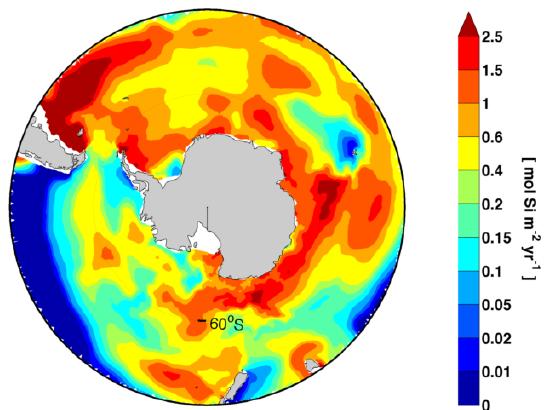
Figure 17. Modelled export of opal across 100m depth plotted to the scale used by Moore et al. (2004).